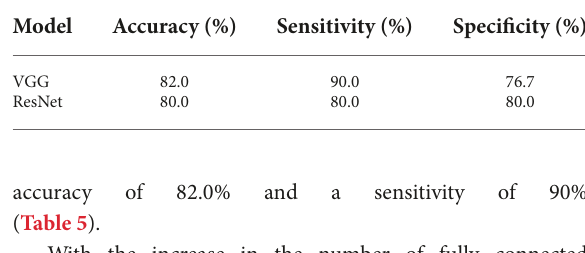
TABLE4 Classification resultsofthe VGGandResNet transferlearning models.